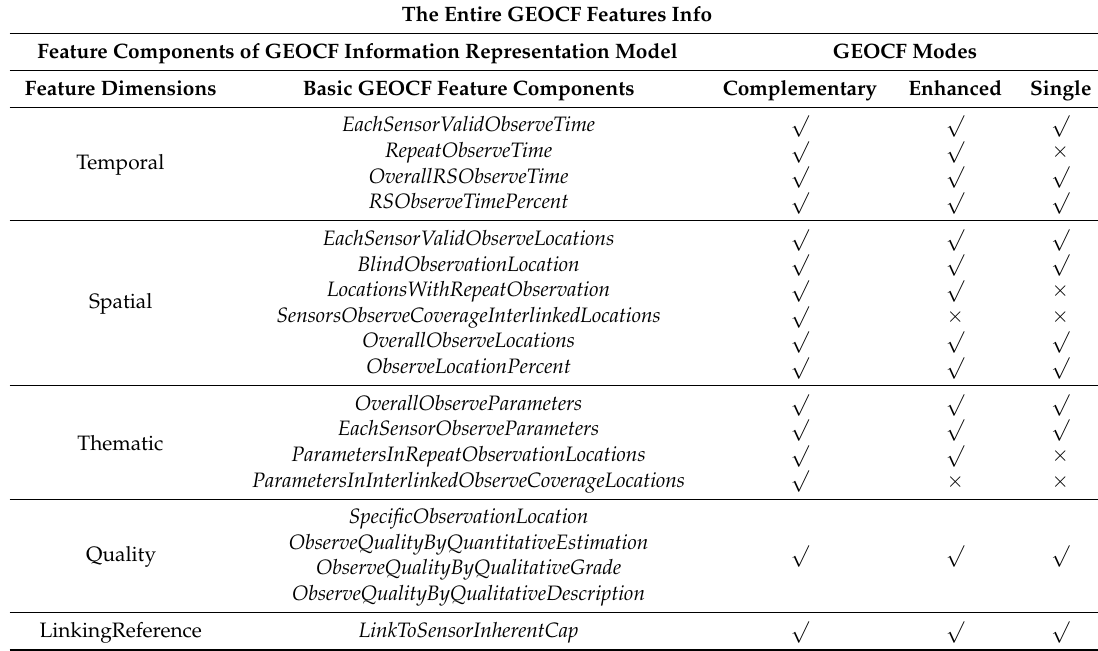
Table 1. Feature components of the GEOCF in different field modes. The Entire GEOCF Features